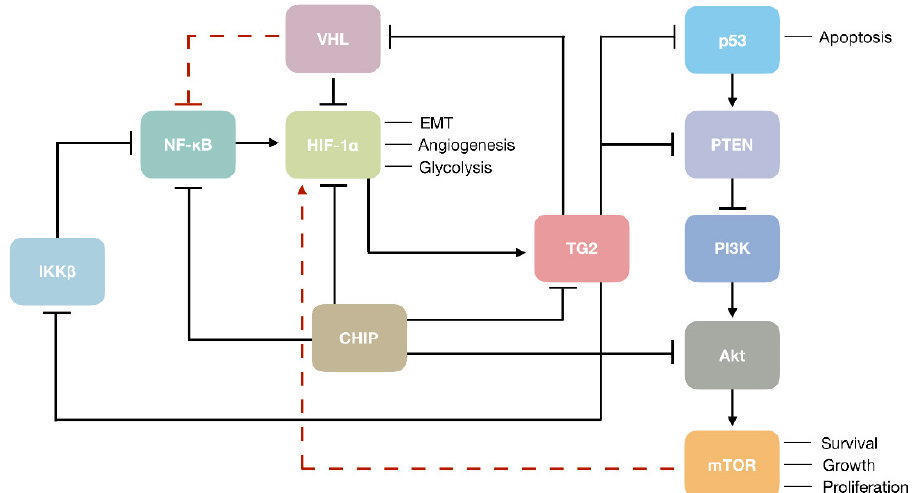
Figure 1. Transglutaminase 2 (TG2) in the modulation of renal cell carcinoma (RCC) oncogenesis. Black arrows and blunt ends show activation and inhibition of target molecules, respectively. Dashed red lines indicate an indirect mechanism of regulation.